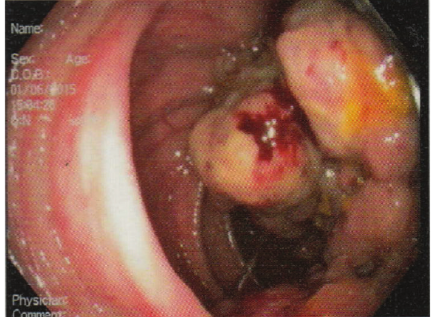
Figure 1: 2D echocardiogram showing large sessile vegetation attached to anterior mitral valve leaflet.